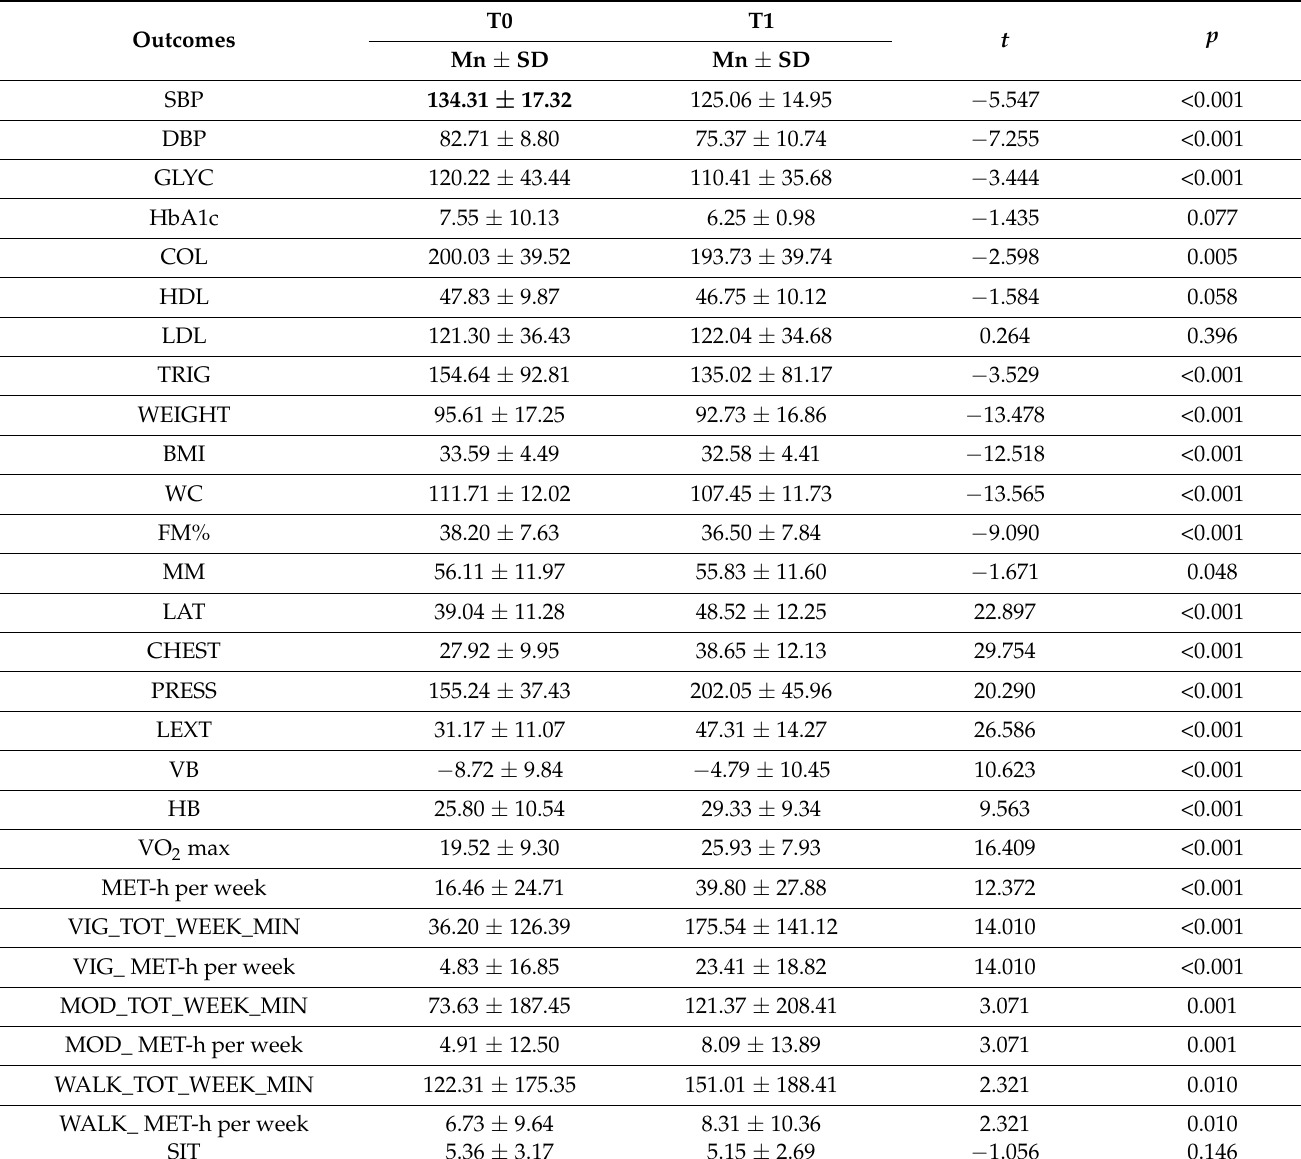
Table 1. Student t -test values: mean values of all parameters in the entire sample. Data are presented as means ± SDs, after (T0) and before (T1) the exercise intervention. Statistical significance was set for p -values ≤